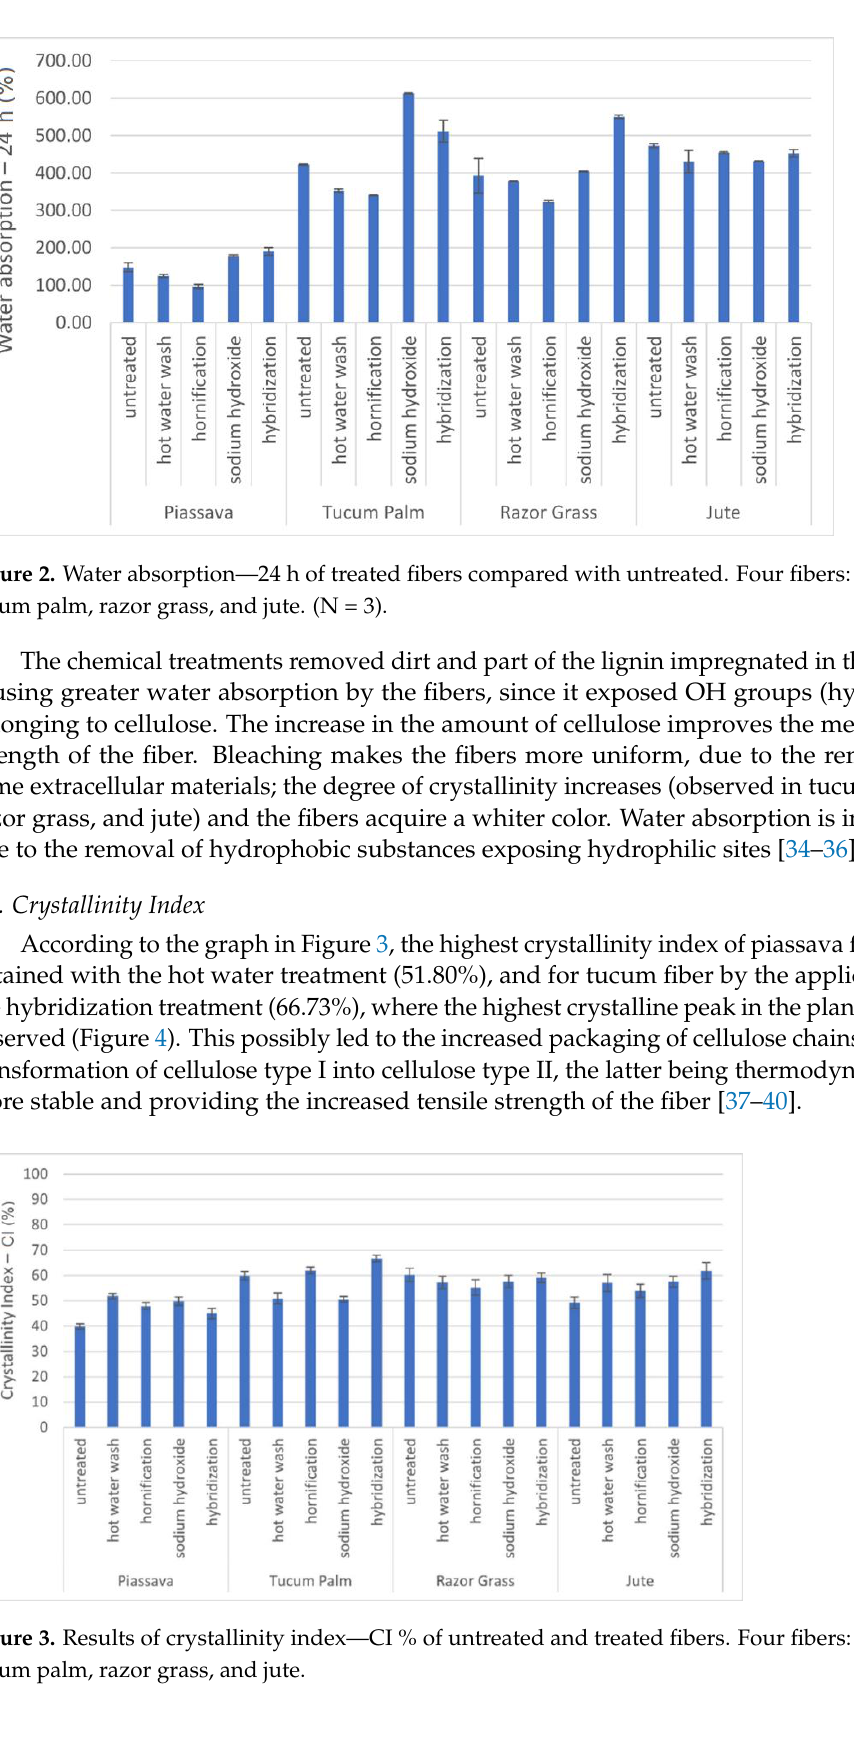
Figure 3. Results of crystallinity index — CI % of untreated and treated fibers. Four fibers: piassava, tucum palm, razor grass, and jute.